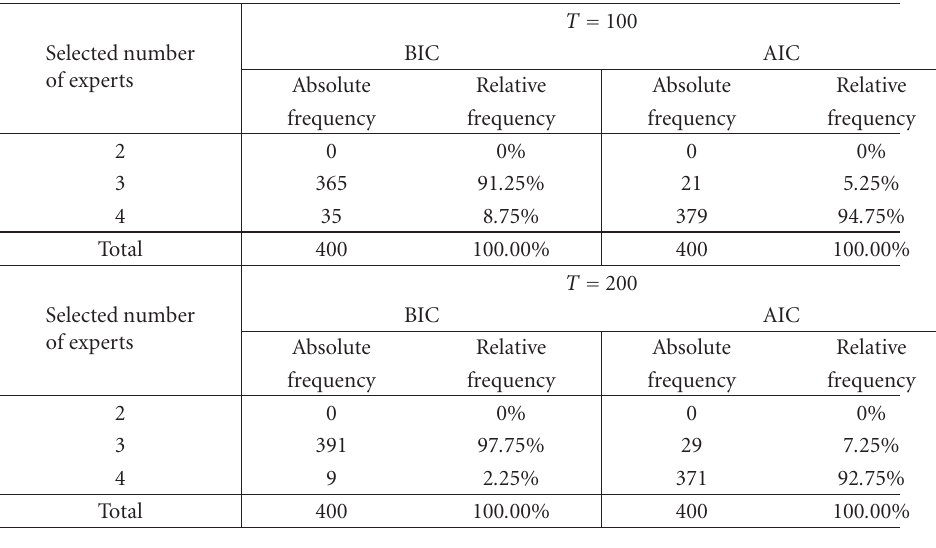
Table 5.1. Mixtures of 3 normal